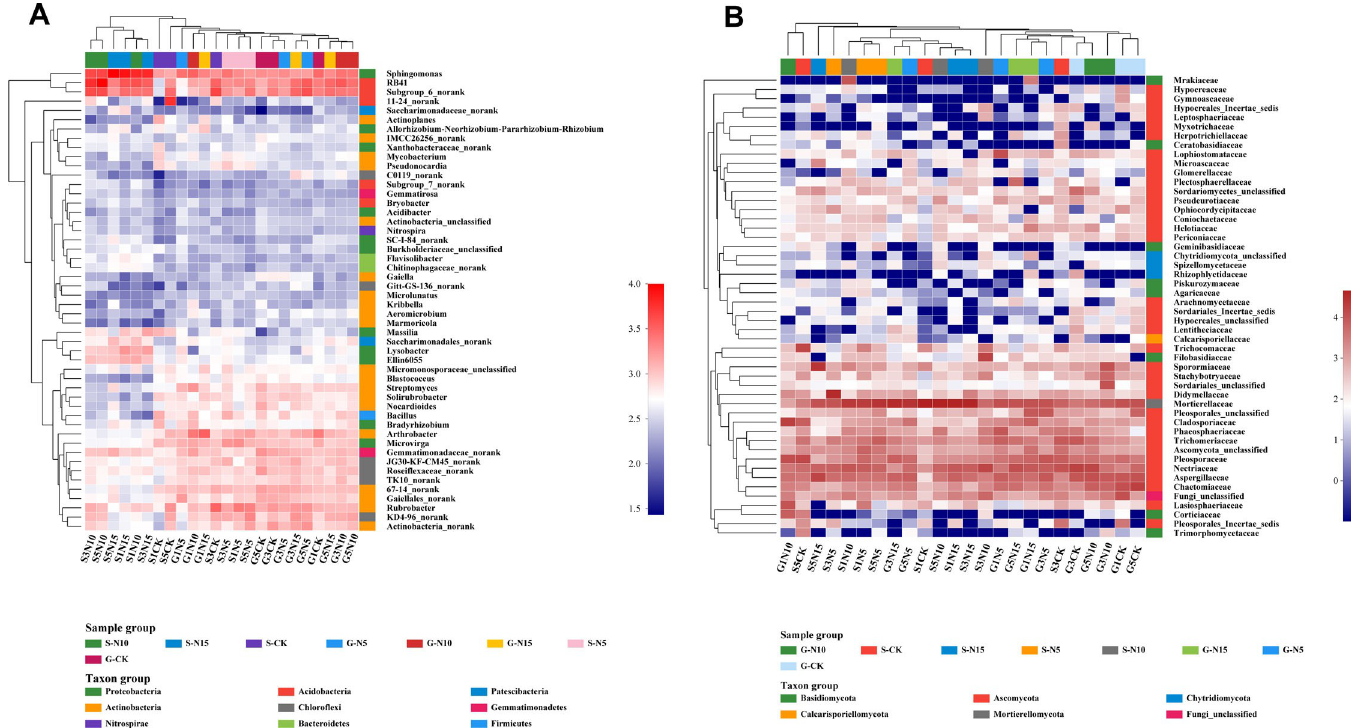
Fig 3. A. Heat map representations and cluster analysis for the microbial community based on 24 samples from the two sampling sites. Bacterial distributions for the 50 most-abundant genera and families. The double hierarchical dendrogram shows the bacterial and fungal distribution. Bacterial and fungal phylogenetic trees were calculated using the neighbor-joining method. Sample names are composed of the sampling site (G, sandy grassland; S, semi-fixed sandy land) and nitrogen addition: Control (CK), no N addition; N5, 5 g N m − 2 yr − 1 ; N10, 10 g N m − 2 yr − 1 ; N15, 15 g N m − 2 yr − 1 . B. Heat map representations and cluster analysis for the microbial community based on 24 samples from the two sampling sites. Fungal distributions for the 50 most-abundant genera and families. The double hierarchical dendrogram shows the bacterial and fungal distribution. Bacterial and fungal phylogenetic trees were calculated using the neighbor-joining method. Sample names are composed of the sampling site (G, sandy grassland; S, semi-fixed sandy land) and nitrogen addition: Control (CK), no N addition; N5, 5 g N m − 2 yr − 1 ; N10, 10 g N m − 2 yr − 1 ; N15, 15 g N m − 2 yr − 1 .